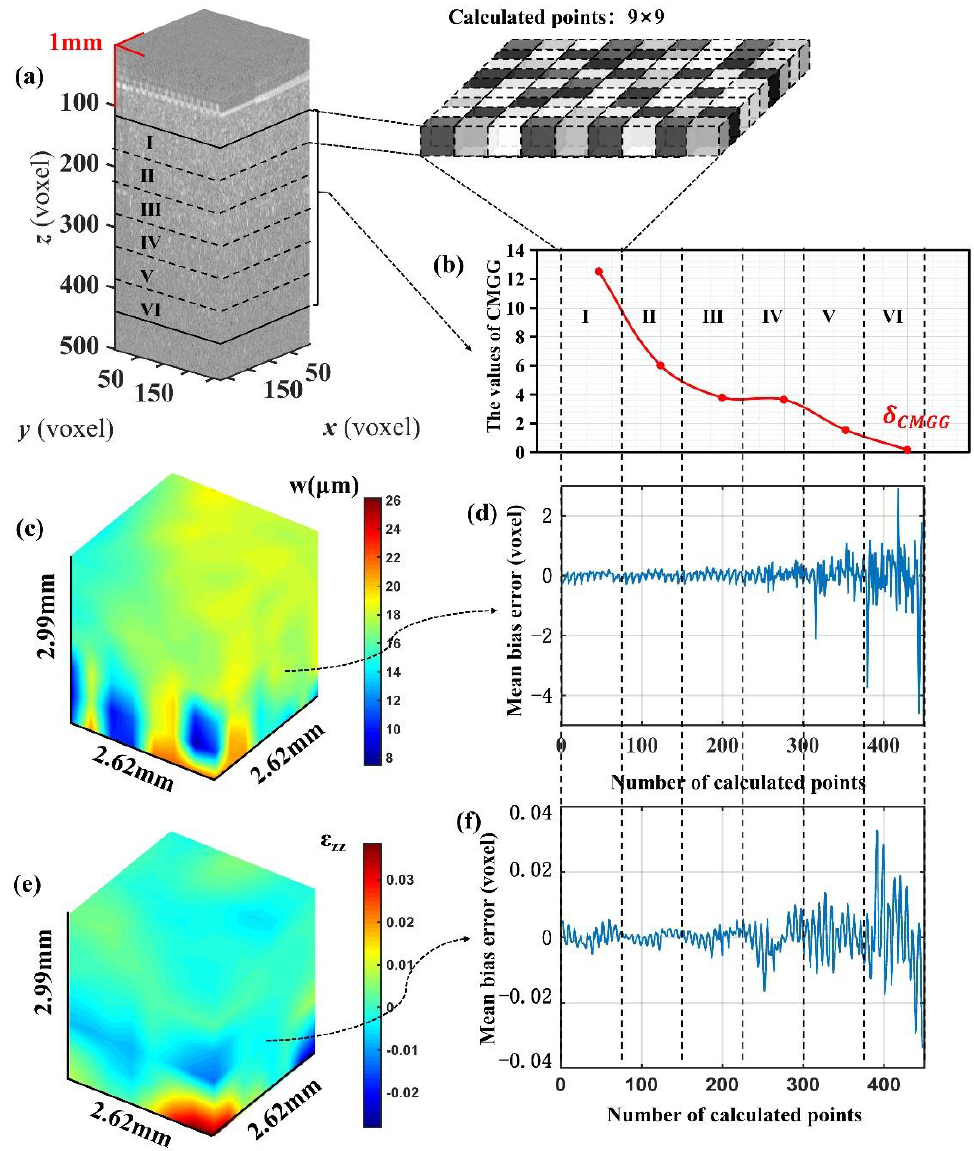
Figure 11. The criteria evaluation in deformation measurement. ( a ) Three-dimensional OCT image of a piece of pork. ( b ) CMGG in different areas. ( c ) The displacement w field along the z direction. ( d ) The mean bias errors of the displacements of 81 points in different parts along the z direction. ( e ) the strain ε zz field along the z direction. ( f ) The mean bias errors of the strains of 81 points in different parts along the z direction.